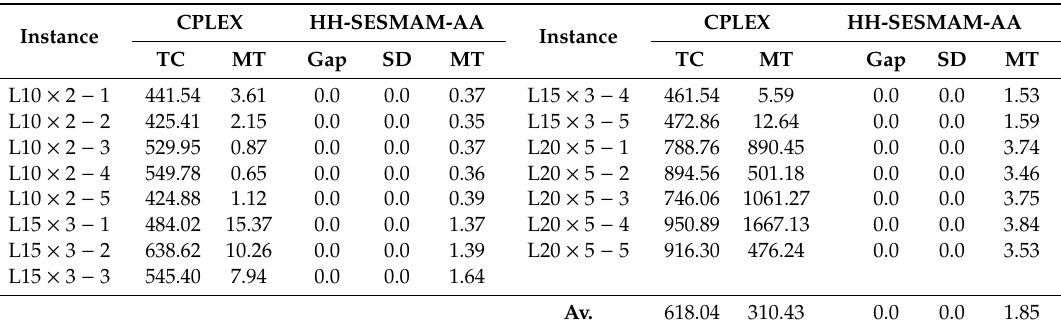
Table 2. Results of small instances.